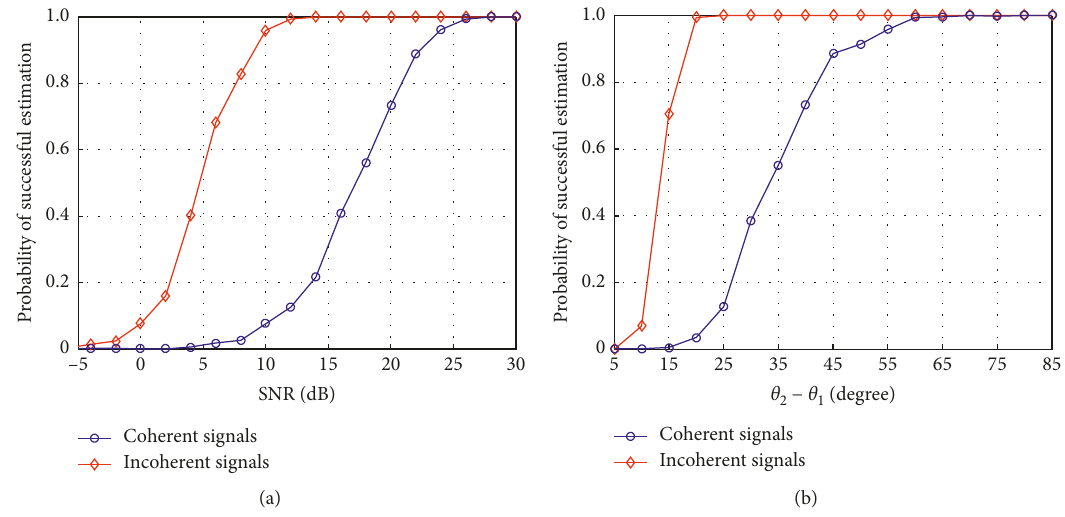
Figure 4: Simulation results of the successful estimation probability in incoherent and coherent cases. (a) Probability of successful es- timation versus the SNR with incident angles of 0 ° and 40 ° . (b) Probability of successful estimation versus incident angles when SNR �